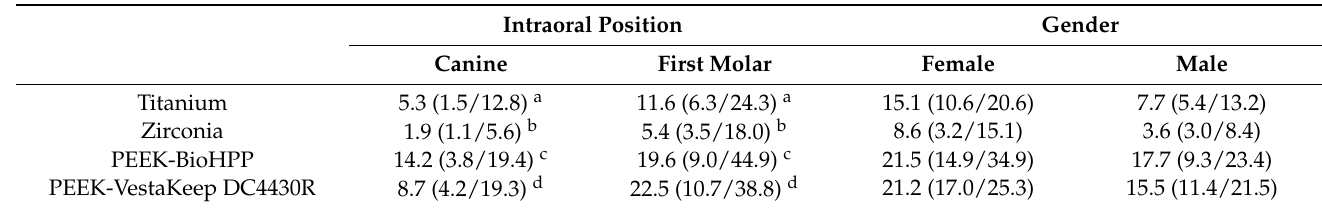
Table 2. Biofilm formation [% of the area] on four different test materials (medians and 25/75 percentiles) in correlation with the localization of the test specimens and the gender of the subjects. Significant differences ( p < 0.05) are indicated by equal letters.